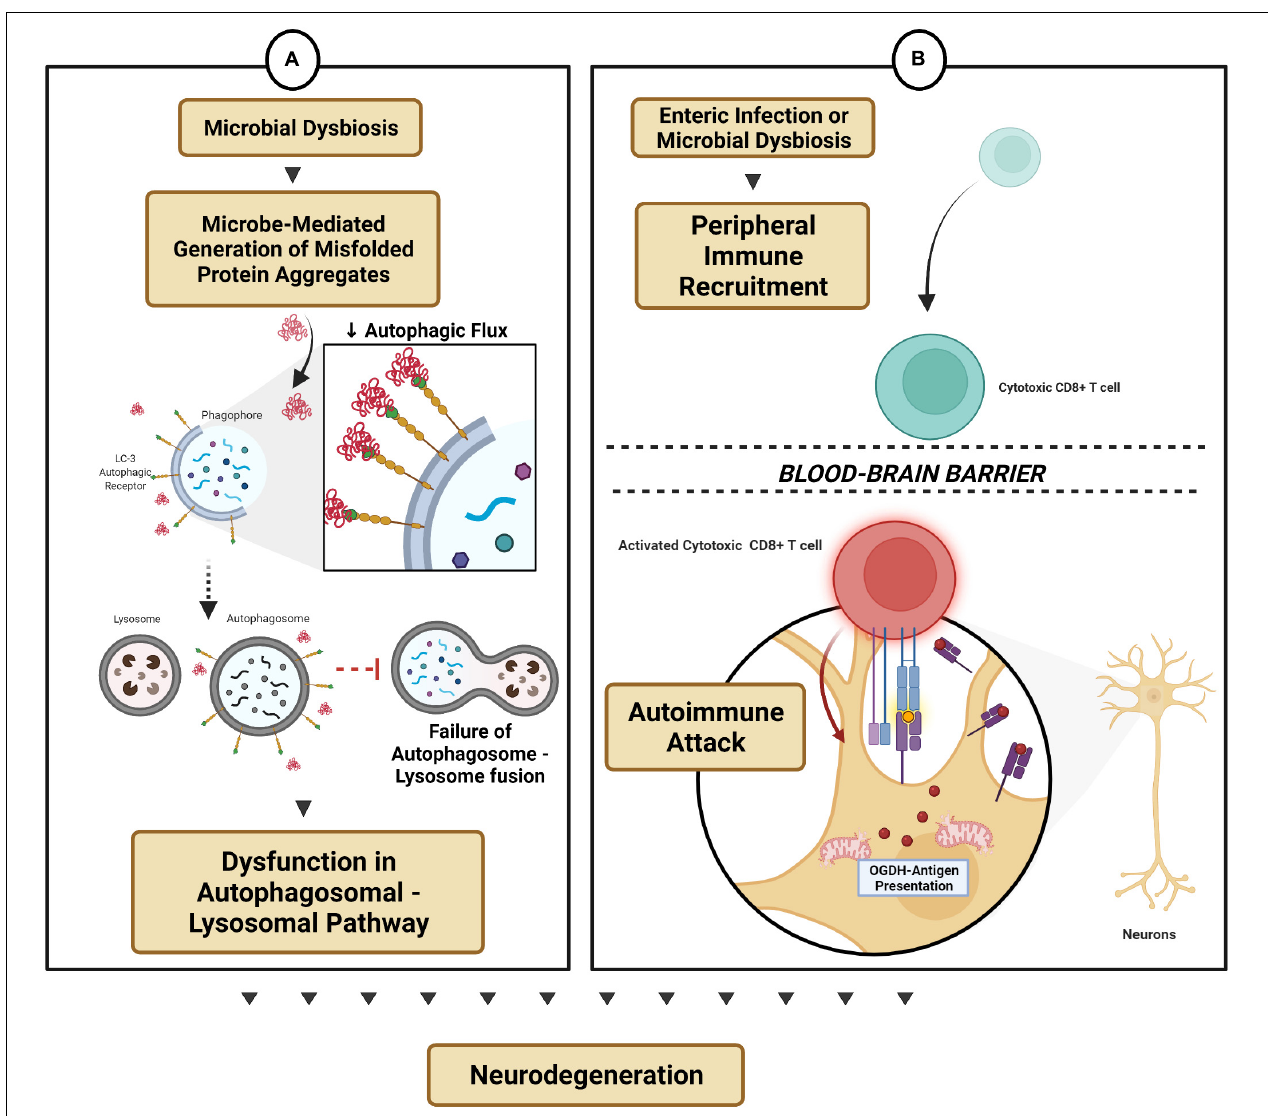
FIGURE 3 | Microbial dysbiosis-modulated protein mechanisms and autoimmune functions. (A) Microbe-mediated generation of protein aggregates reduces autophagic flux and thereby dysregulates the autophagosomal-lysosomal pathway. (B) Enteric infection triggers peripheral immune recruitment into the CNS by gaining access across the blood–brain barrier, thereby triggering an autoimmune attack on subsets of neurons (e.g., dopaminergic neurons).